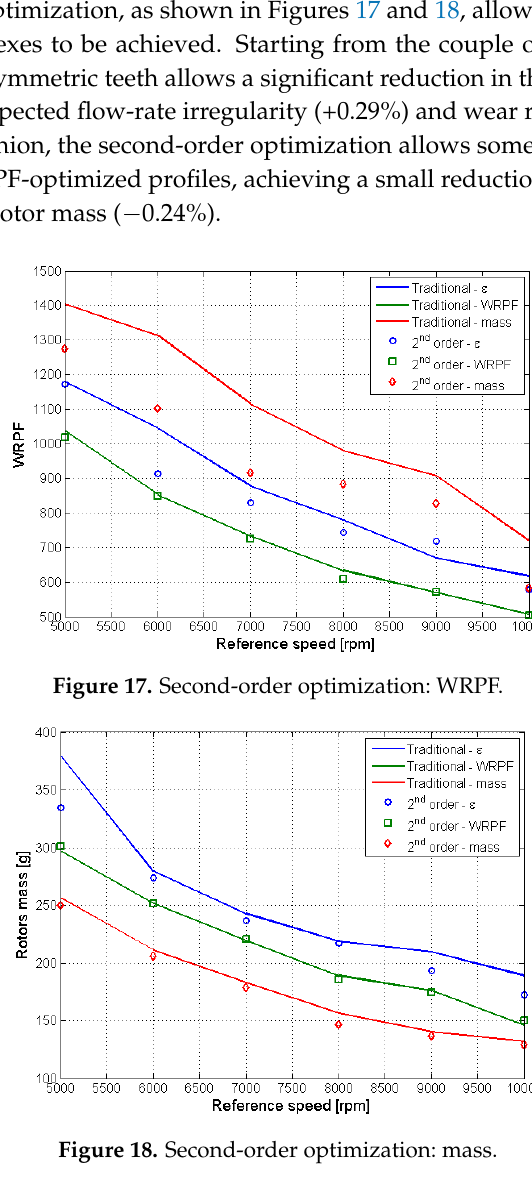
Figure 19. Example of second-order optimization for n = 7000 rpm. 7. Discussion and Further Work The optimization activities described in this paper have proven that asymmetric lobes are able to provide several advantages over the traditional profile for gerotor pumps operating in the same direction for the most part of their operative life. At first, the theory and the design framework implemented in this work have been presented and discussed, and hence used inside the optimization loops. The proposed optimization procedure consists of two steps; the first one being the optimization of the traditional profile to define the lobe sizes along the radial direction, and hence applying a second-order procedure to optimize the lobe shapes. Following this procedure, the half- side of the teeth involved in significant force exchange is optimized, to minimize the estimated wear rate, while the other half is modified to reduce the predicted mass and flow irregularity. It has been proven that through the use of asymmetric lobes, it is possible to obtain better performances over each of the considered performance indexes, with respect to the optimum that is obtainable for the traditional cycloidal profile. In particular, the results suggest marked performance improvements for those mobile applications where weight reduction is the most significant issue, such as the aerospace field, where gerotor pumps can be used in the lubrication systems of the aircraft engines. Further work will include a comparison between the different shapes of the two half-lobes, and eventually applications towards multi-curve geometries.